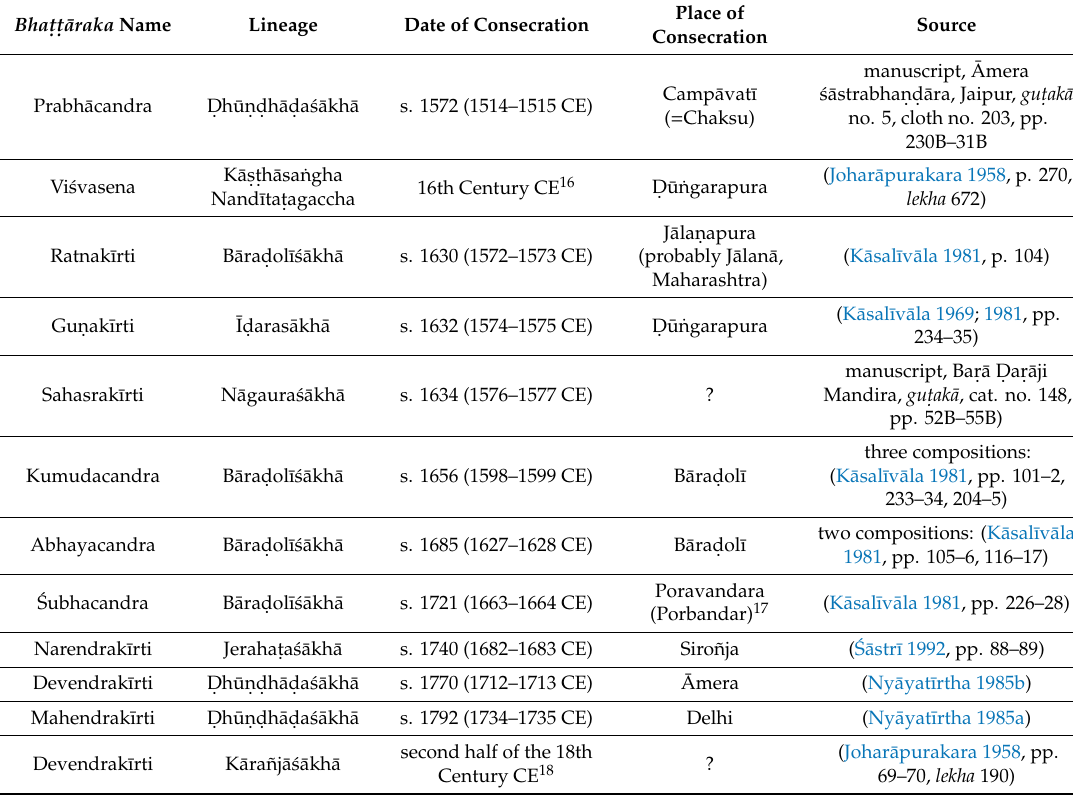
Table 1. Chronological list of bhat.t.¯araka consecrations attested in song